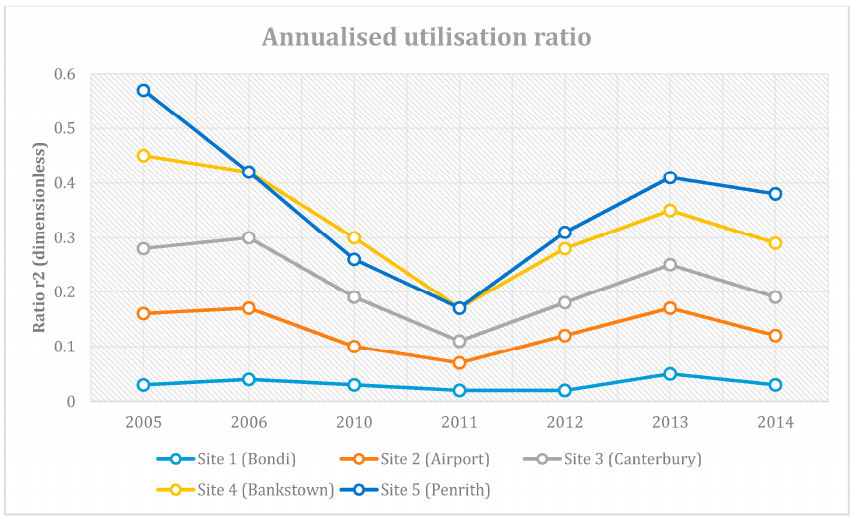
Figure 8. Annualised utilisation ratio (R 2 ) for Sydney sites for each simulation year.